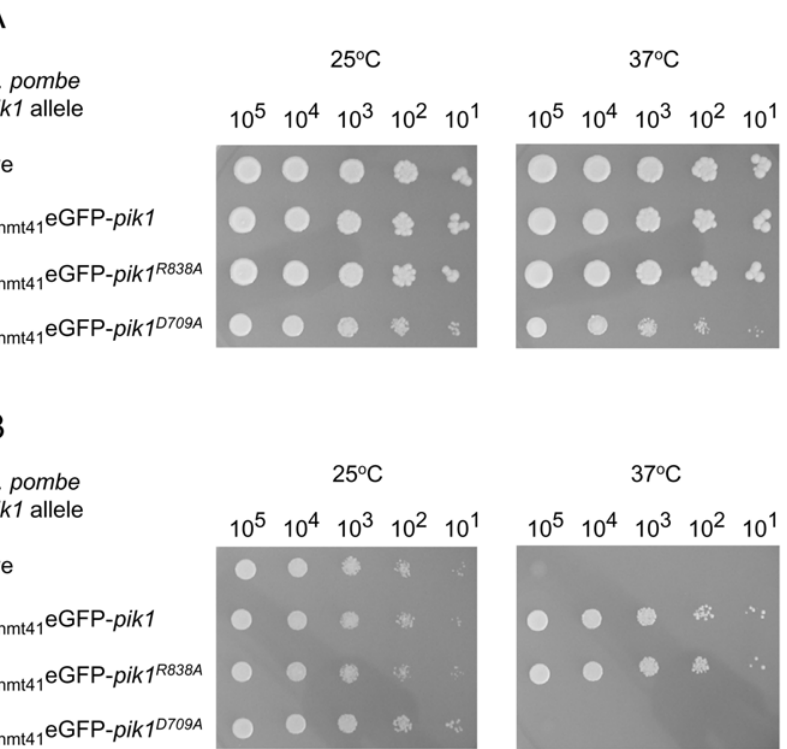
Figure 10. Complementation of S.cerevisiaepik1-101 by heterologous expression of S.pombepik1 alleles. Colony formation assays. (A) S.cerevisiae PIK1 cells were transformed with empty YEplac181 as negative control (-ve), or with YEplac181 recombinants that expressed eGFP fusions to wild-type Pik1 under the control of an attenuated nmt1 promoter (P nmt41 -eGFP- pik1 ), or the same construct carrying either the D709A or R838A substitutions. To assay for colony formation at 25 u C or 37 u C, aliquots from serial dilutions of each culture, containing the number of cells indicated, were prepared and spotted onto SD-Leu plates lacking thiamine which were incubated for 5 days. (B) The experiment as described in (A) was performed with S.cerevisiae pik1-101 cells. The colony formation assays were replicated independently at least three times. The results shown are representative of each of the replicates.